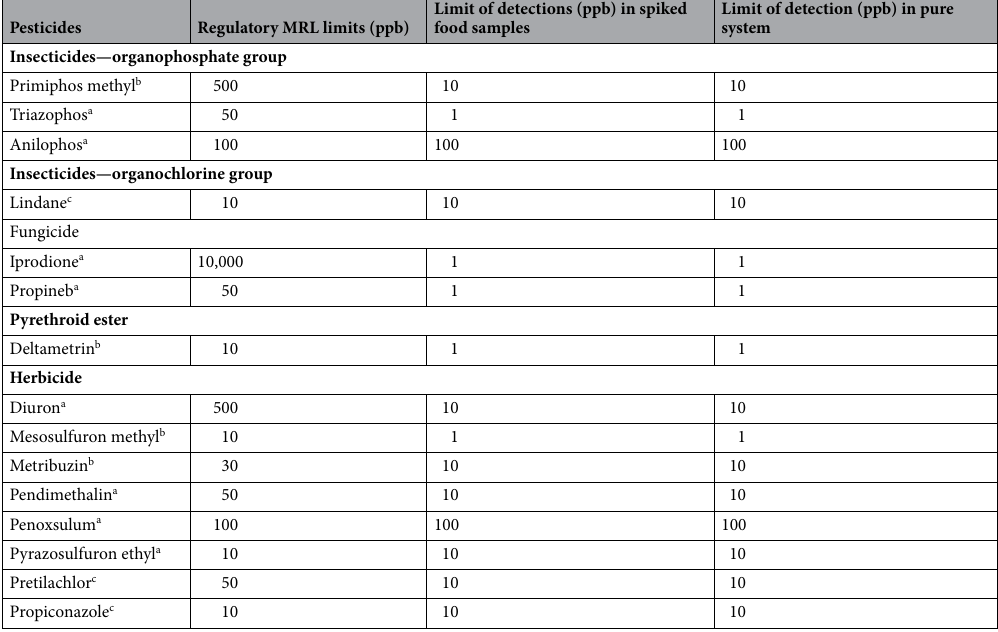
Table 1. LOD of different group of pesticide from cereal based foods sample. a Rice, b Wheat, c